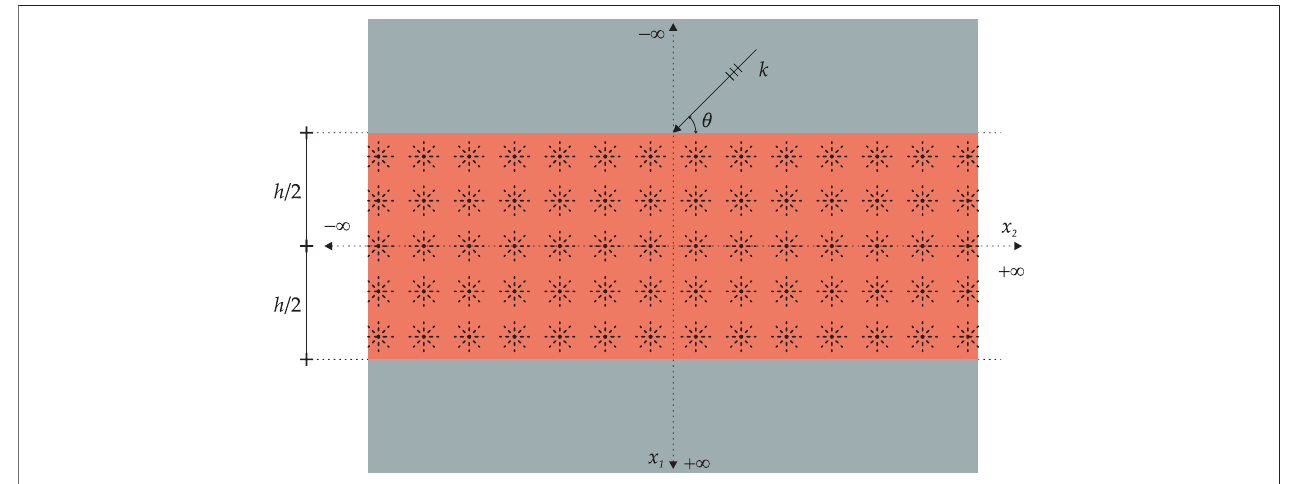
FIGURE1| Schematicrepresentationofawavewithwavenumber k hittingatangle θ arelaxedmicromorphicslabofthickness h embeddedbetweentwoisotropicCauchymedia.